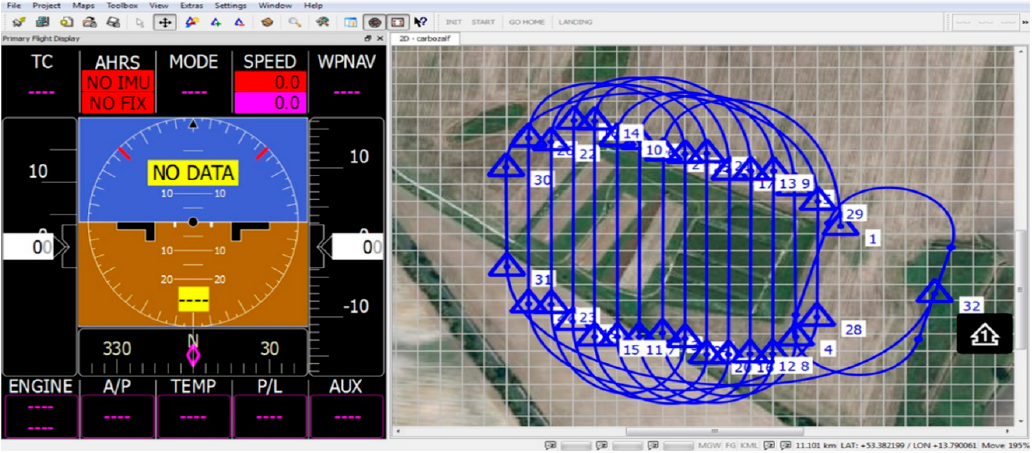
Figure 4. Screenshot of the MAVCDesk software. ( Left ) Primary flight display (not active) showing UAV status information; ( Right ) Visualization of the flight path across a map of the CarboZALF experimental area.